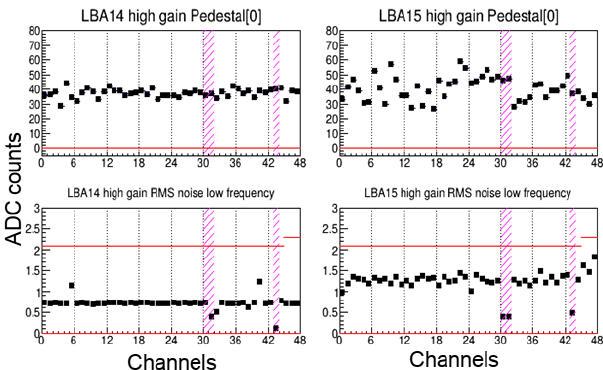
Fig. 7. Average pedestal noise for the Demonstrator module (left) and for a contiguous legacy module (right). The Demonstrator presents lower noise levels compared with the legacy